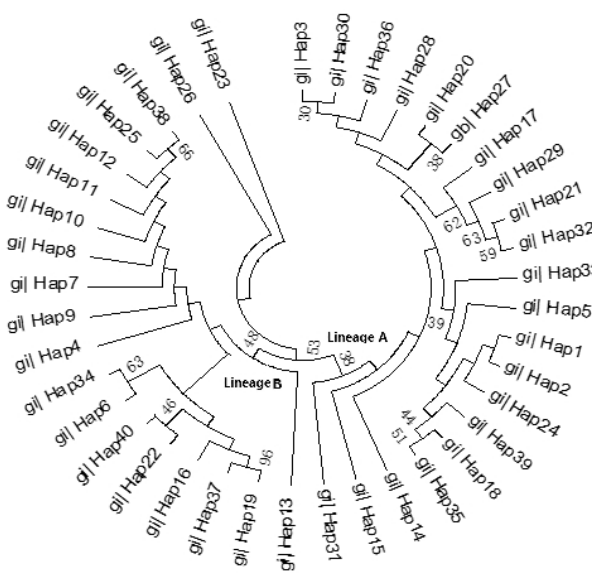
Figure 3. Maximum likelihood tree of 40 haplotypes from 12 cattle breeds based on mtDNA 16S rRNA gene